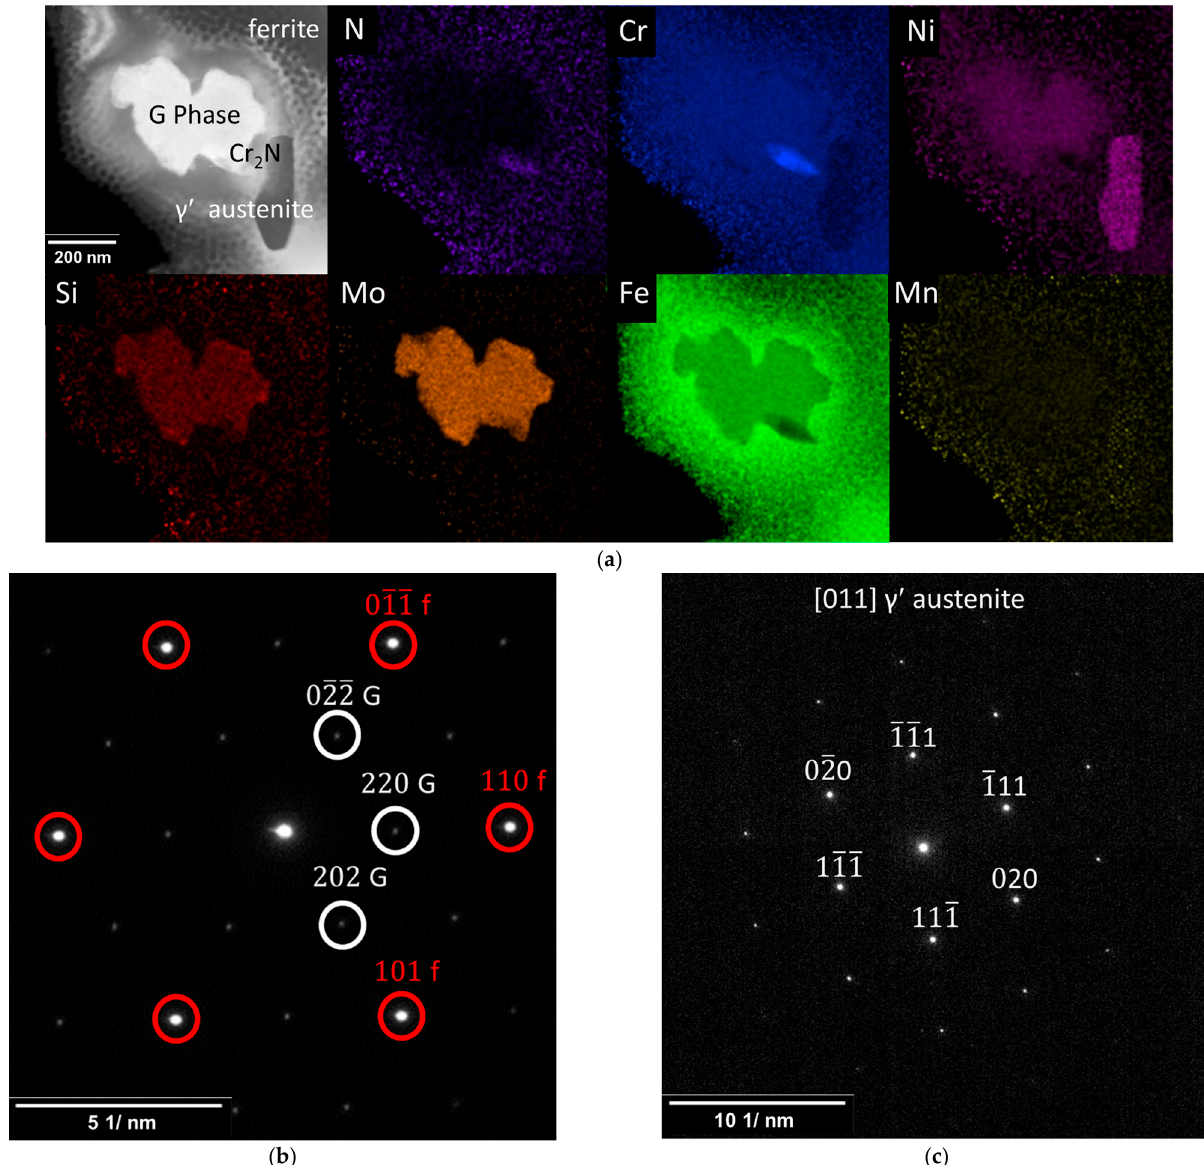
Figure 5. Detailed STEM images of the ferritic grain after isothermal fatigue at 600 °C. ( a ) HAADF- STEM image of the G phase, Cr 2 N and γ′ austenite in a ferritic grain and the corresponding EDX mapping of the elements N, Cr, Ni, Si, Mo, Fe and Mn. Point EDX analysis data of the phases are given in Table 2. ( b ) SAD image of the G phase and the ferrite matrix along (cid:4670)1 (cid:3364) 11(cid:4671) G / (cid:4670)1 (cid:3364) 11(cid:4671) α zone axis. ( c ) SAD image of γ′ austenite at [011] zone axis.